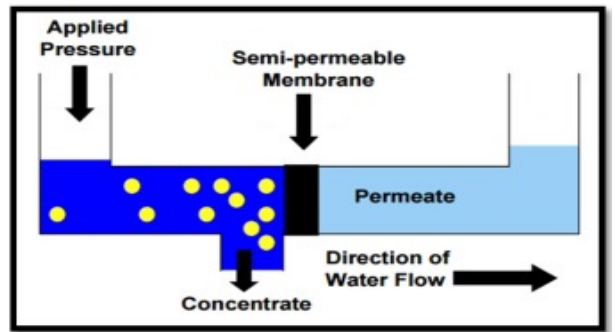
Figure 2. Reverse osmosis mechanism